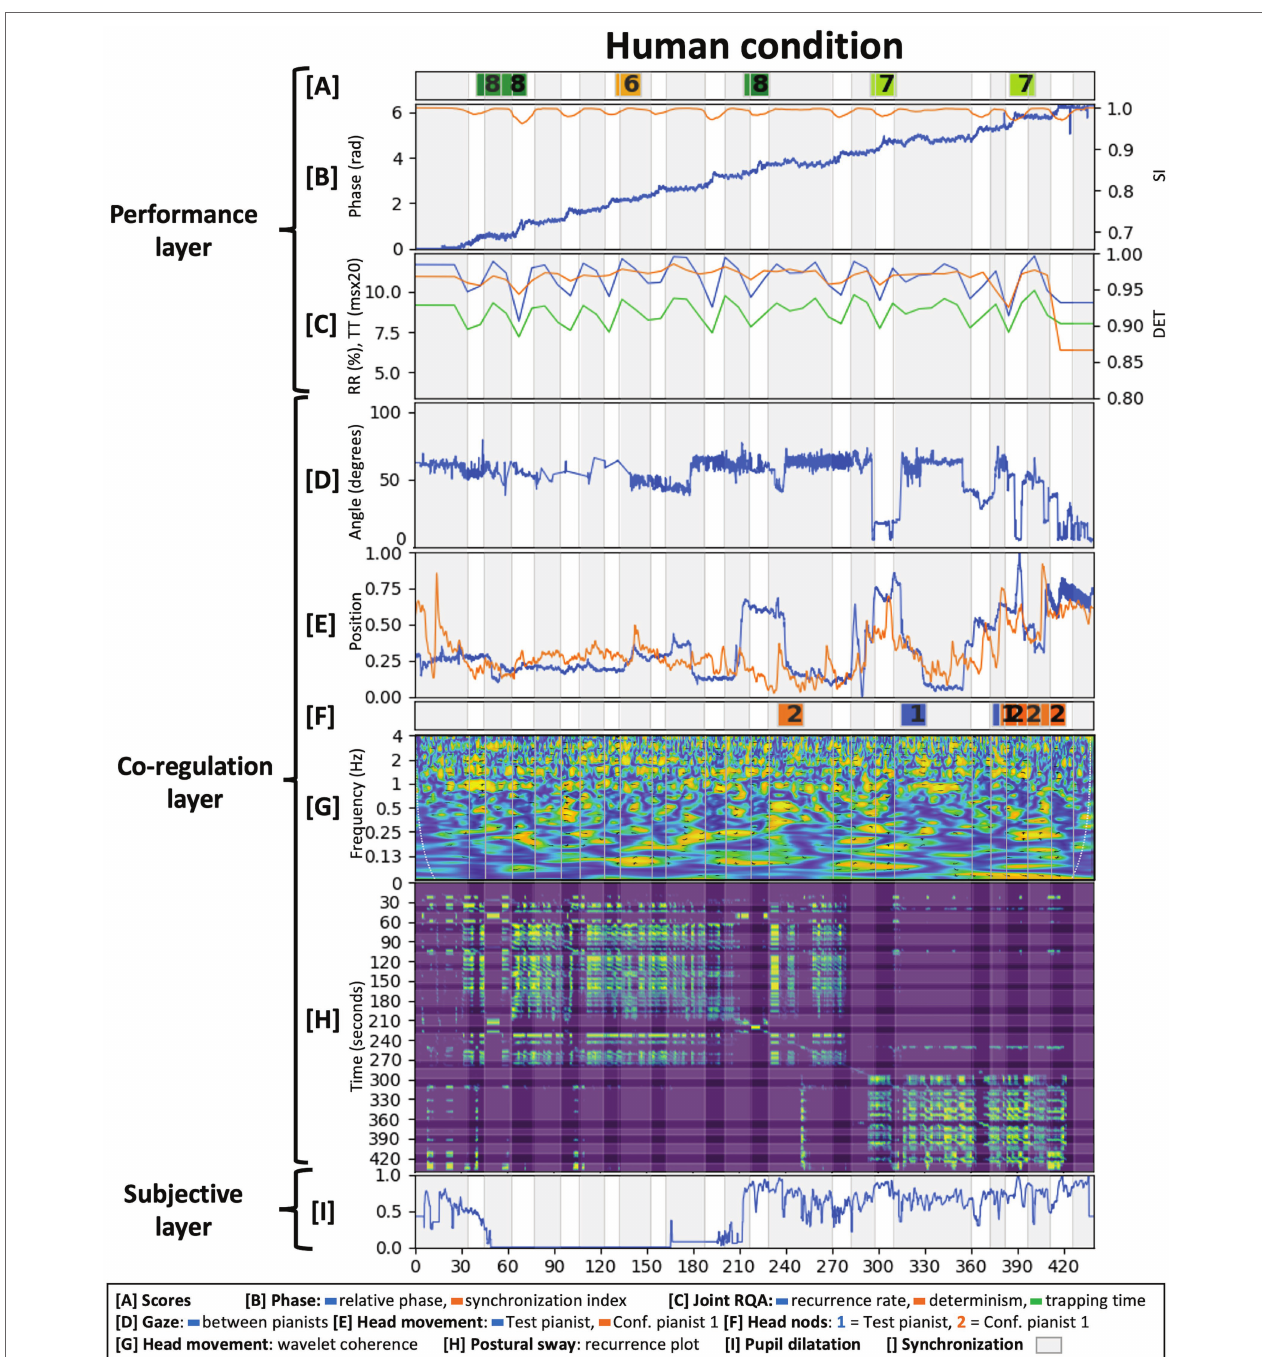
FIGURE 6 | Analysis of the human condition across the three interrelated layers from the proposed methodological